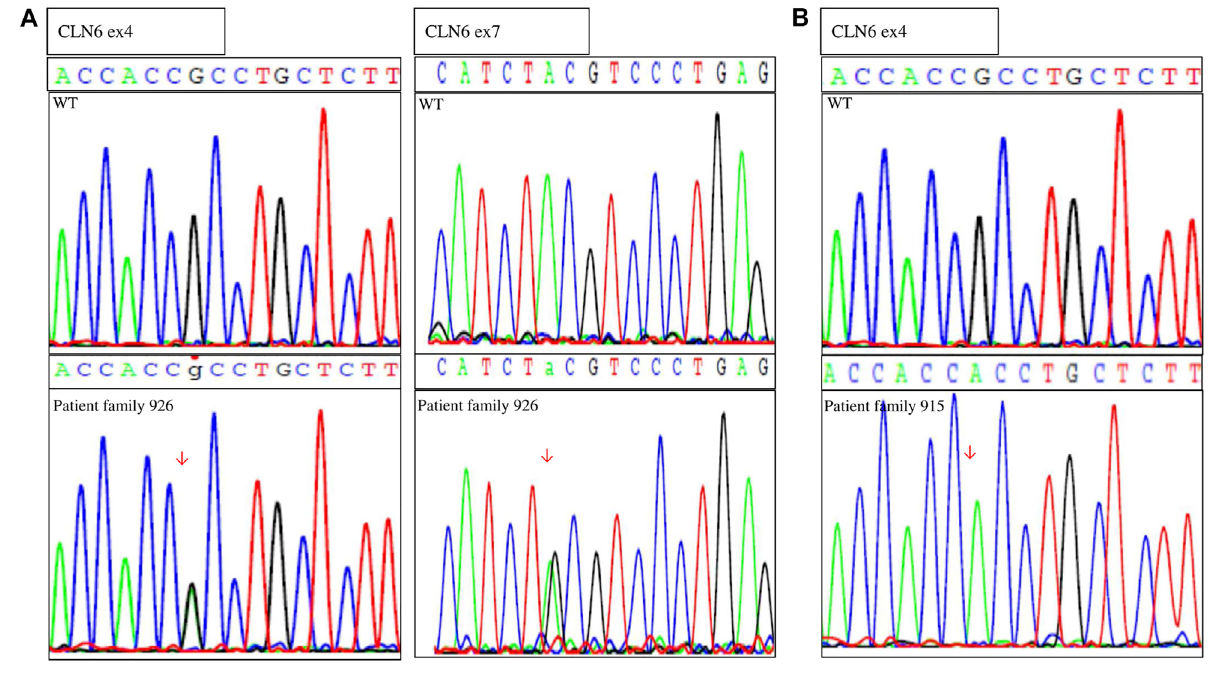
Frontiers in Genetics |